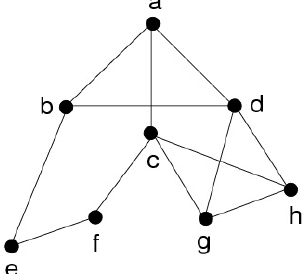
Figure 3 . A non-chordal graph G . The set of minimal separators of G